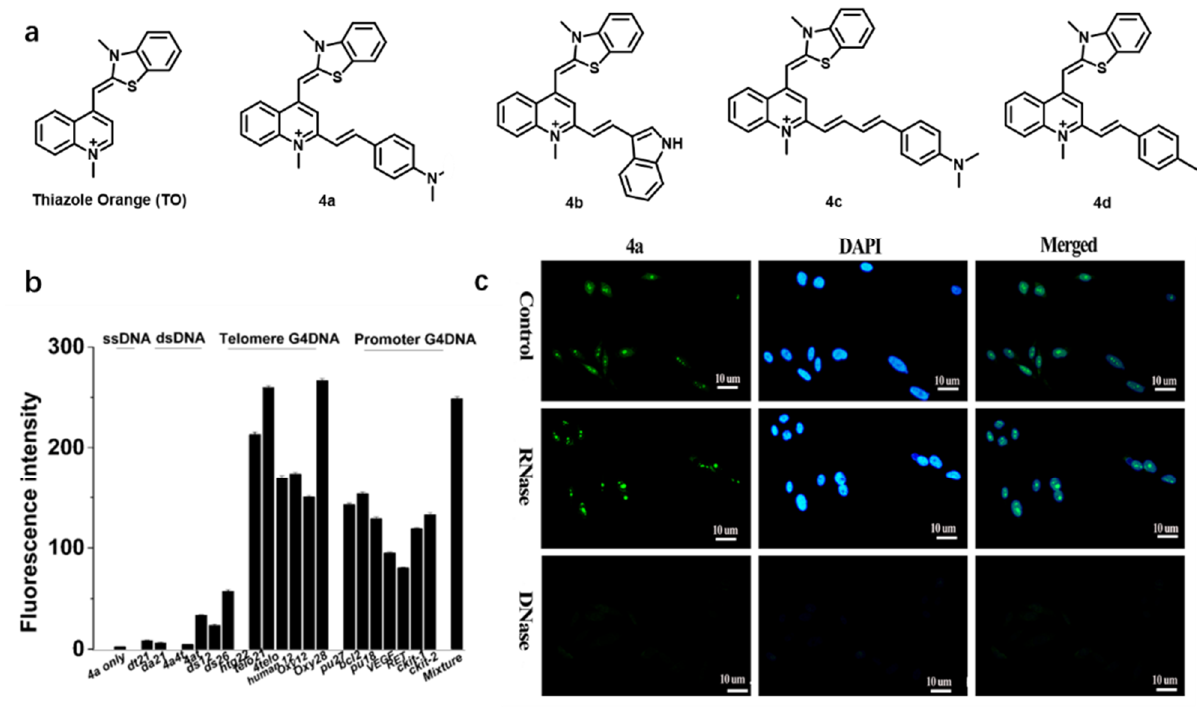
Figure 16. ( a ) Structures of TO, 4a, 4b, 4c and 4d. ( b ) Fluorescence intensities at 630 nm (λ ex = 475 nm) of 4a with different nucleic acids in Tris-HCl buffer containing 60 mM KCl. Single-stranded DNA: da21, dt21. Duplex DNA: 4a4t, 4at, ds12 and ds26. Telomere G-quadruplex DNA: htg22, telo21, 4telo, human 12, oxy12 and oxy28. Promoter G-quadruplex DNA: bcl2, ckit-1, ckit-2, Pu27, Pu18, RET and VEGF. ( c ) Fluorescence images of PC3 cells (fixed) stained with 5.0 μM of 4a for 15 min and 1.0 μg/mL DAPI for 5 min without and with DNase or RNase treatment. 1000× magnification was utilized in the imaging. Scale bar is 10 μm. Reproduced from [58] with permission from the Royal Society of Chemistry, Copyright 2014.